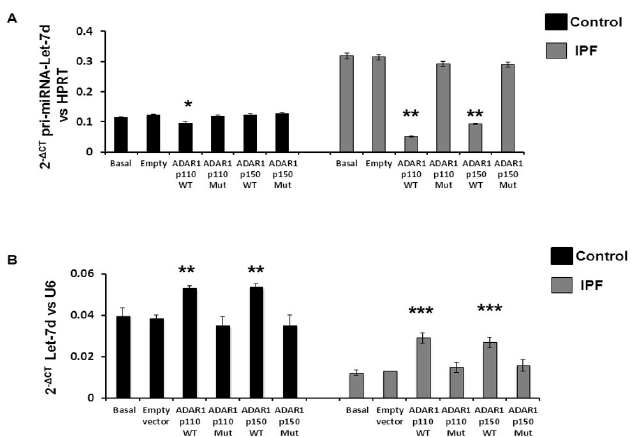
Figure 6. The expression of pri-miR-Let-7d is modified by the over-expression of ADAR1-p110 wt and ADAR1-p150 wt. In ( A ), the over-expression of ADAR1-p110 wt in control fibroblasts significantly decreases the expression of pri-miR-Let-7d (* p = 0.054479, black bars). In IPF fibroblasts, both isoforms promote the decrease in pri-miR-Let-7d . ADAR1-p110 wt (** p = 0.0002108, gray bars) and ADAR1-p150 wt (** p = 0.00038554) in a higher proportion compared to the control fibroblasts. The expression of Let-7d in ( B ) was increased in the fibroblasts transfected with ADAR1. In control fibroblasts transfected with ADAR1, the expression of Let-7d is increased significantly ADAR1-p110 wt (** p = 0.001477, black bars) and ADAR1-p150 wt (** p = 0.001946, black bars). In IPF fibroblasts, the over-expression of catalytically active isoforms promotes a significant increase in Let-7d . ADAR1-p110 wt (*** p = 0.000151, gray bars) and ADAR1-p150 wt (*** p = 0.000855, gray bars).